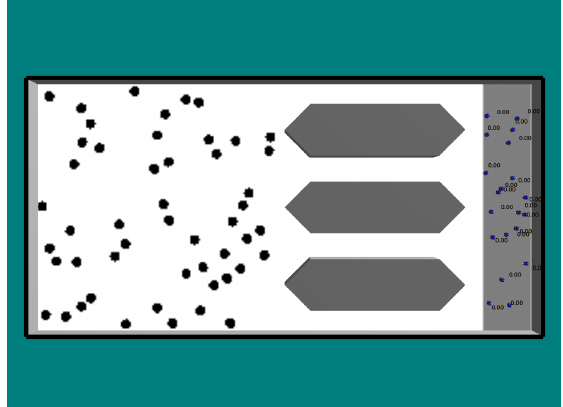
Figure 5. Screenshot of second simulated environment used. Food items are shown as black circles in the white environment, puck robots can be seen waiting in the nest area (light grey). Obstacles creating corridors are illustrated in dark